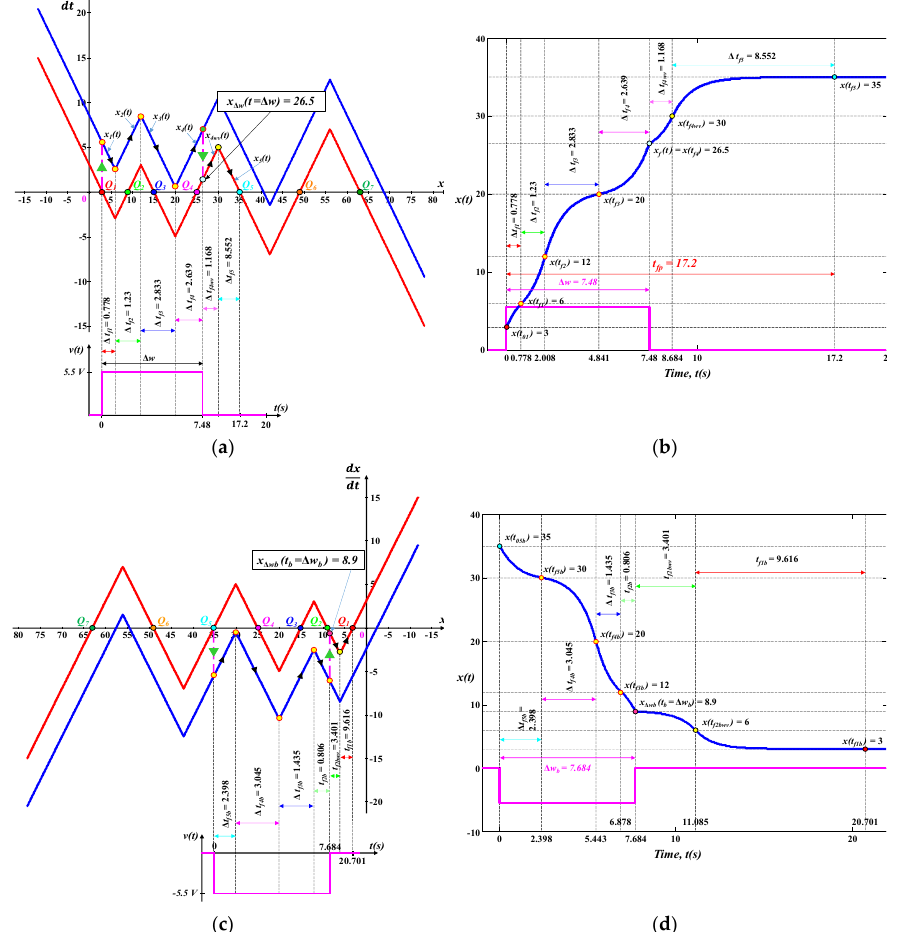
Figure 4. Memory states switching kinetics of the 6-lobe CCM . ( a ) Successful switching from lower conductance state Q 1 to higher conductance state Q 5 and ( b ) movement of the exponential trajectories of x n (t) with respect to time, t, for an input square pulse V A = 5.5 V and Δw = 7.48 s. ( c ) Successful switching from higher conductance state Q 5 to lower conductance state Q 1 and ( d ) movement of the exponential trajectories of x n (t) with respect to time, t, for an input square pulse V A = −5.5 V and Δw b = 7.684 s.